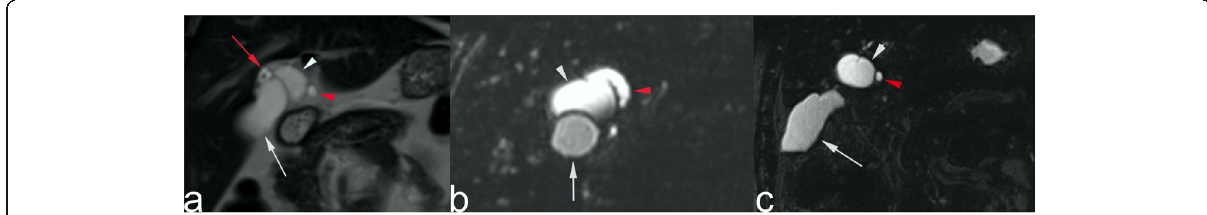
Fig. 1 a On T2-weighted images, saccular dilatation is observed in the middle part of the cystic duct (type VI biliary cyst) (white arrowhead). The gallbladder (white arrow) and the proximal (red arrow) and distal cystic duct (red arrowhead) are normal. b On axial and c coronal MRCP images, similar to T2-weighted images, saccular dilatation is observed in the middle part of the cystic duct (white arrowhead). It is seen that the gallbladder (white arrow) and distal cystic duct (red arrowhead) are normal and distal cystic duct relationship with cystic dilatation is more